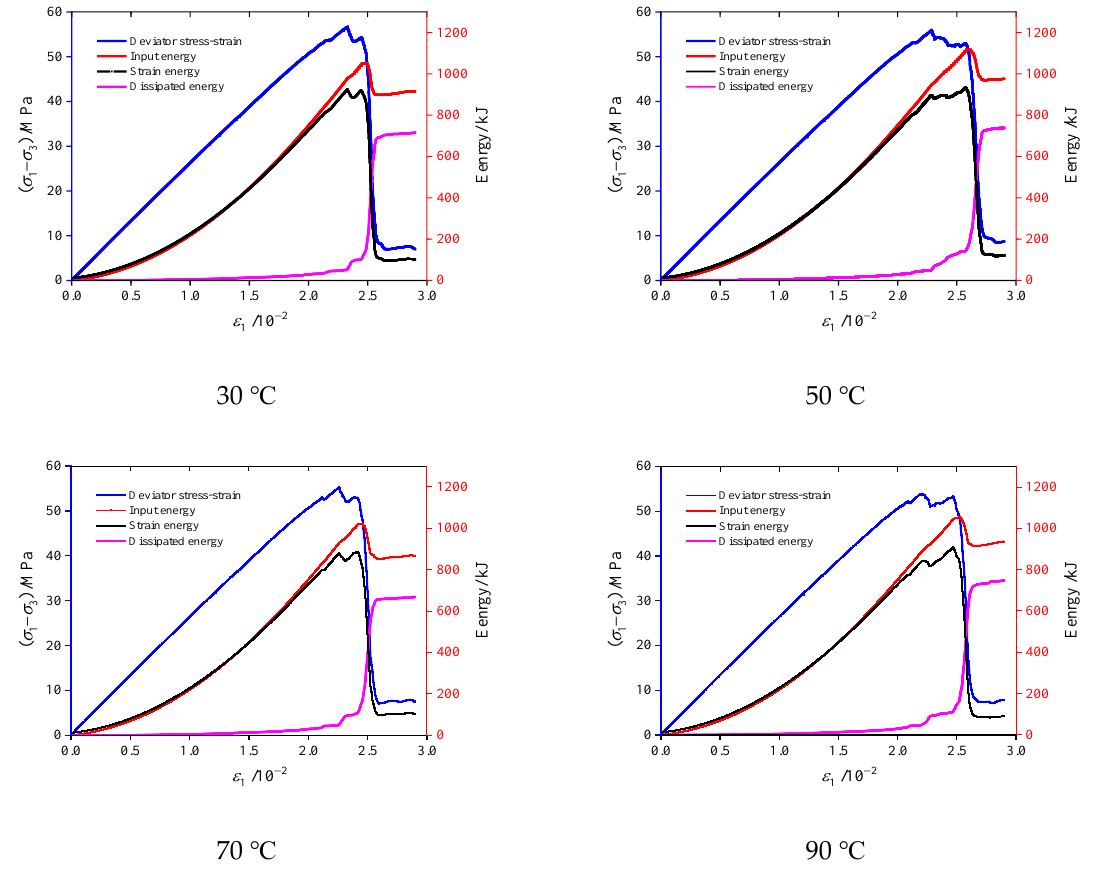
lagged behind the peak stress. This is because the larger macro fracture was not formed, and the elastic energy could not start a large number of releases.